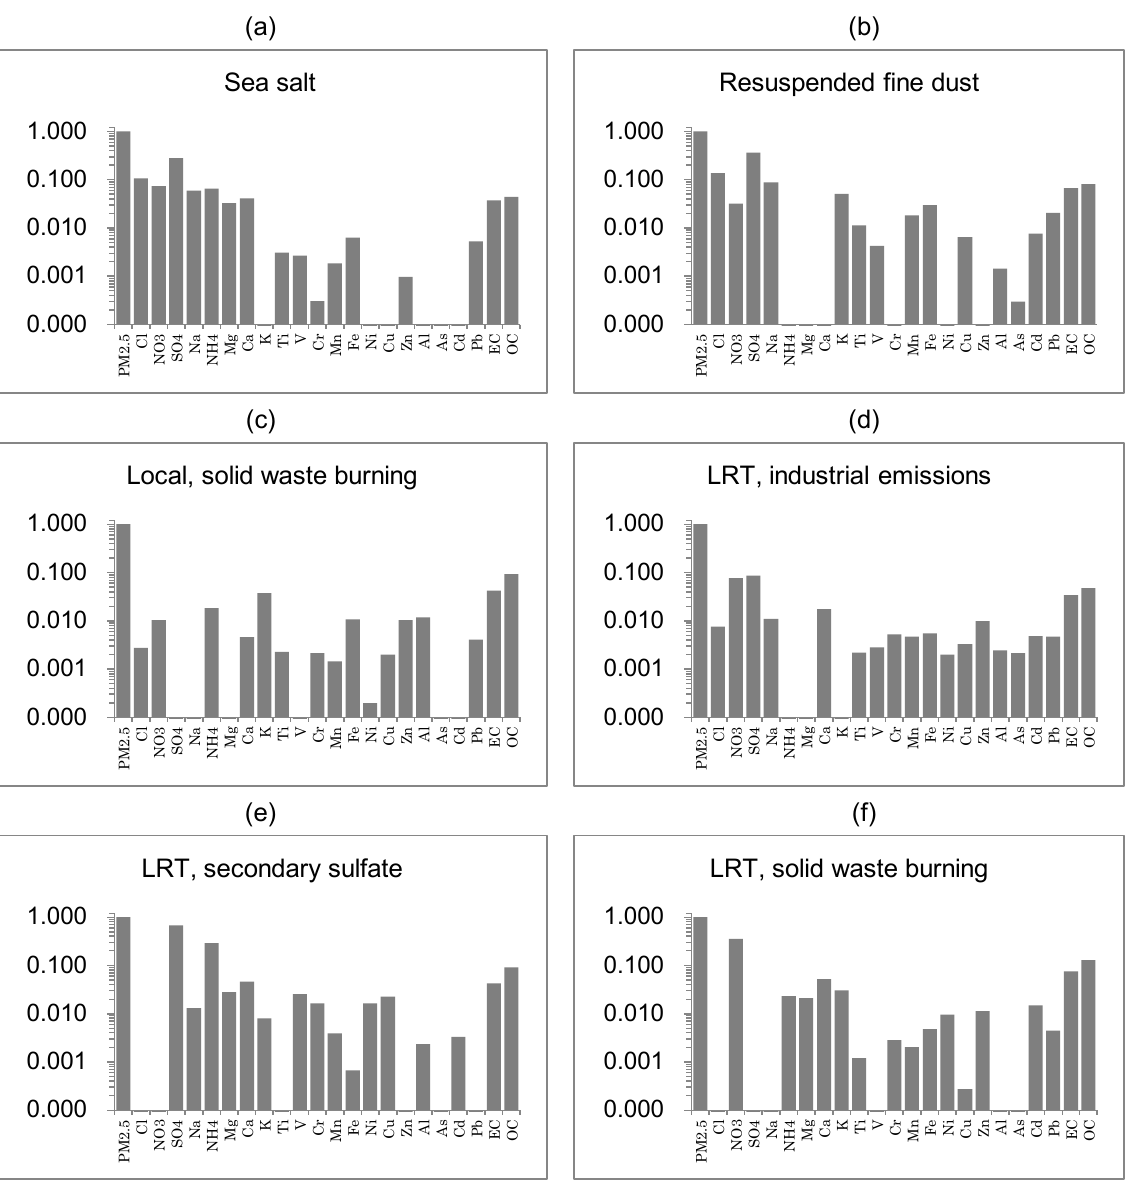
Figure 10. Source factor profiles from PMF analysis: (a) sea salt, (b) resuspended fine dust, (c) local, solid waste burning, (d) LRT, industrial emissions, (e) LRT, secondary sulfate and (f) LRT, solid waste burning.